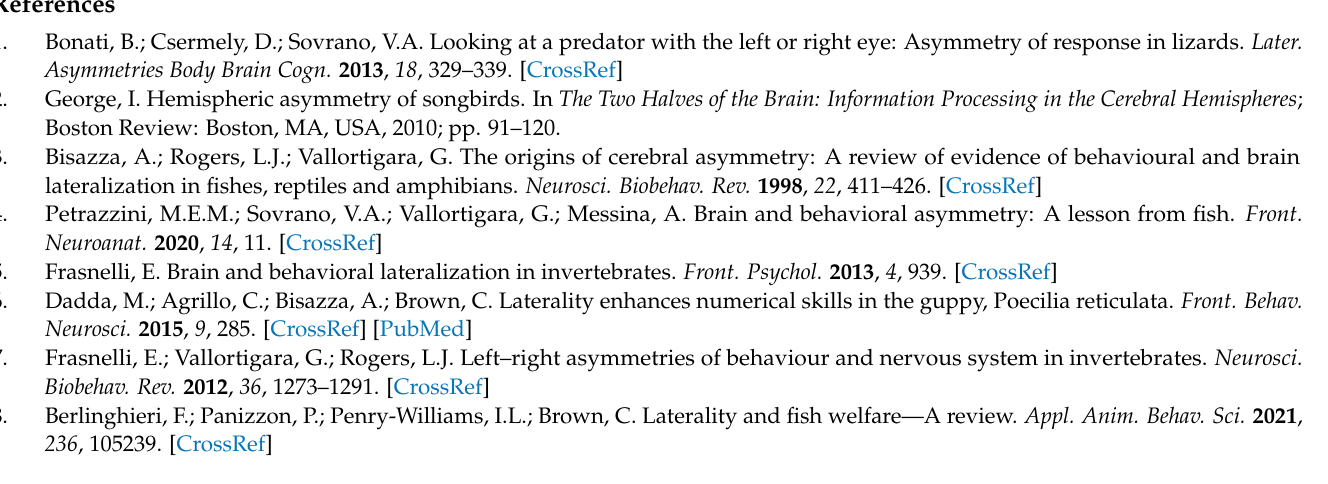
Figure S2: The emmeans comparisons of absolute laterality (absolute value of the laterality index) between wild-caught (W) and captive (C) individuals, where arrows represent comparisons, and arrows which do not overlap represent significant